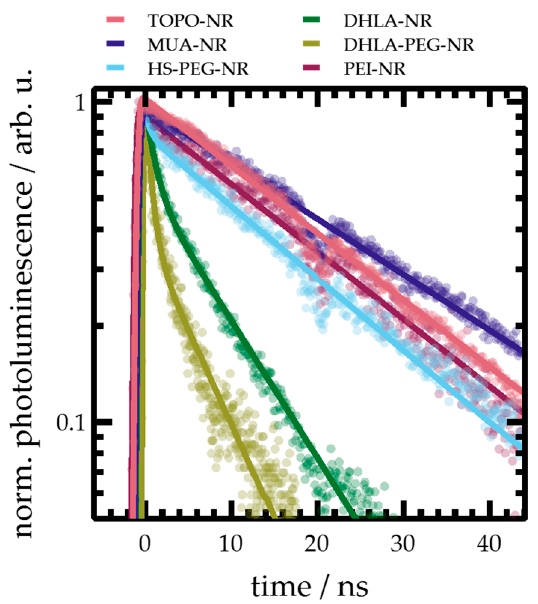
Figure 3. Time-resolved photoluminescence decay of samples investigated measured in toluene (TOPO-NR) or water (all other samples). The solid line represents a mono- or biexponential fit of the data (dots), respective fit parameters are summarized in Table 2. Table 2. Time-resolved photoluminescence spectroscopy on NR with di ff erent surface ligands. Time constants were obtained via a mono- or biexponential fit. For the biexponential fits, the amplitudes of the respective component are indicated. Additionally, the rate of radiative recombination k rad , which was calculated from Equation (1) using τ 2 , is also